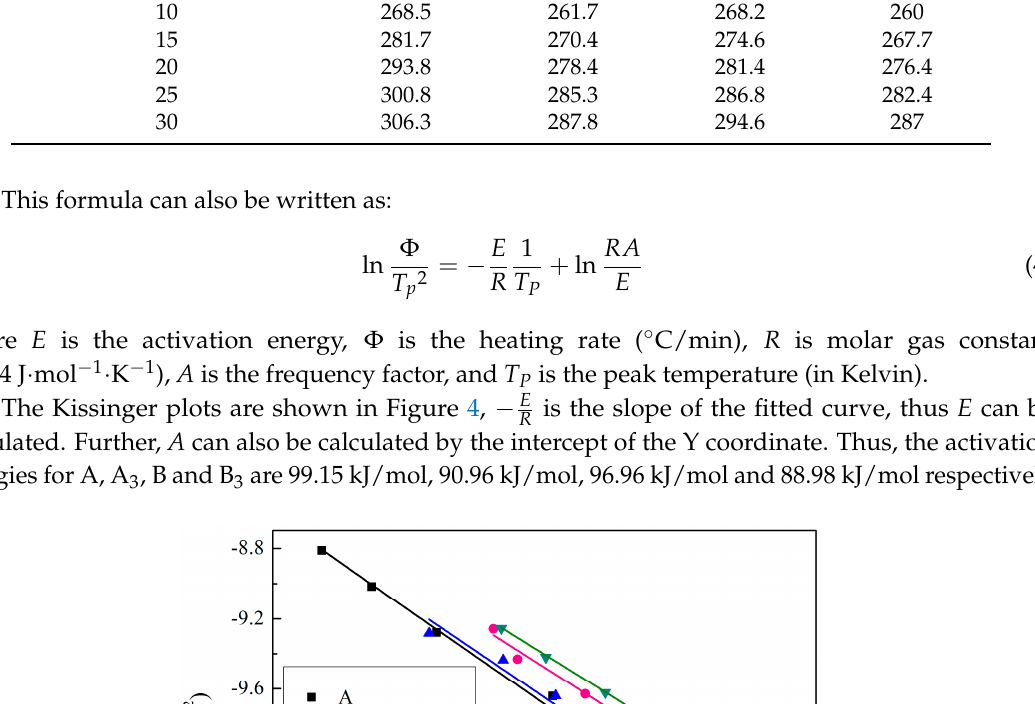
Φ /( T 2 as a function of ( T p )